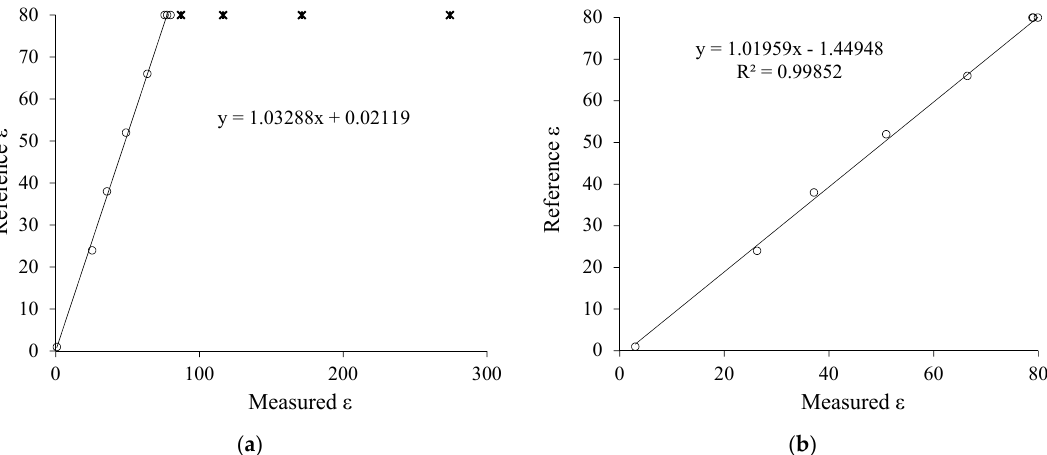
Figure 7. ( a ) Approximation method to estimate σ ; ( b ) real-dual-frequency method to estimate σ .